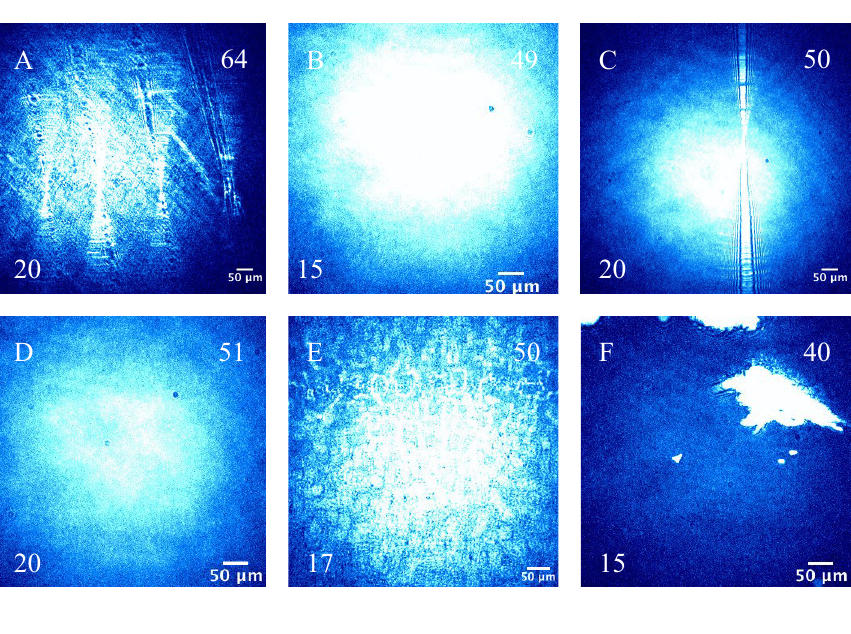
Figure 11. BAM images of the collapse phase of mixed PA/cerebrosides monolayers for various compositions: ( A ) 0:1; ( B ) 1:4; ( C ) 2:3; ( D ) 3:2; ( E ) 4:1; ( F ) 1:0. Mean molecular area (Å 2 /molecule) and surface pressure (mN/m) values are indicated in the bottom left and top right corners,